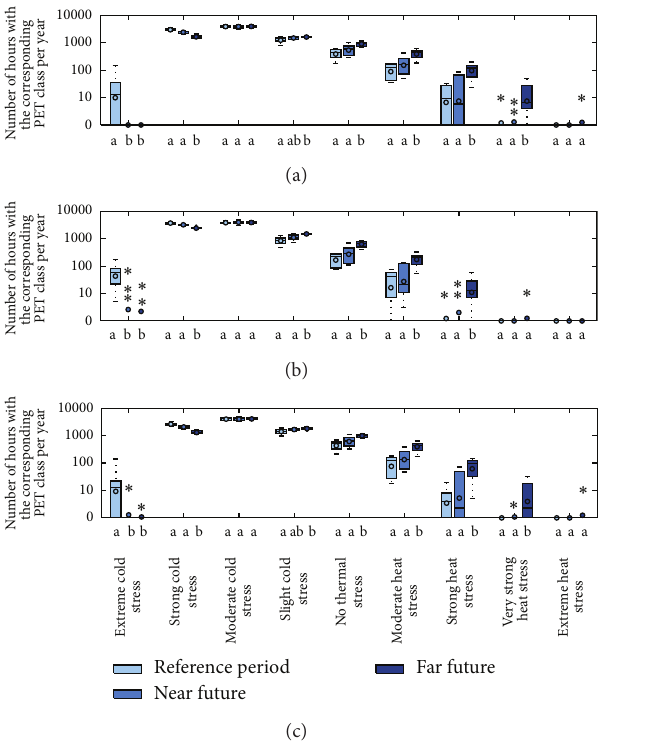
Figure 5: Boxplots of PET values for the three periods: reference period 1991–2000, near future 2041–2050, and far future 2091–2100 at the three pseudo stations Esch-sur-Alzette (a), Reuler (b), and Wasserbillig (c). Boxplots show the number of hours within the corresponding PET class per year. The whisker length is determined by 1.5 ∗ interquartile range (IQR). All values larger than 1.5 ∗ IQR are treated as outliers. Median values are indicated by the line inside the box, mean values by the dot. Groups that are sharing the same letters are not significantly different ( 𝑃 < 0.05 ).